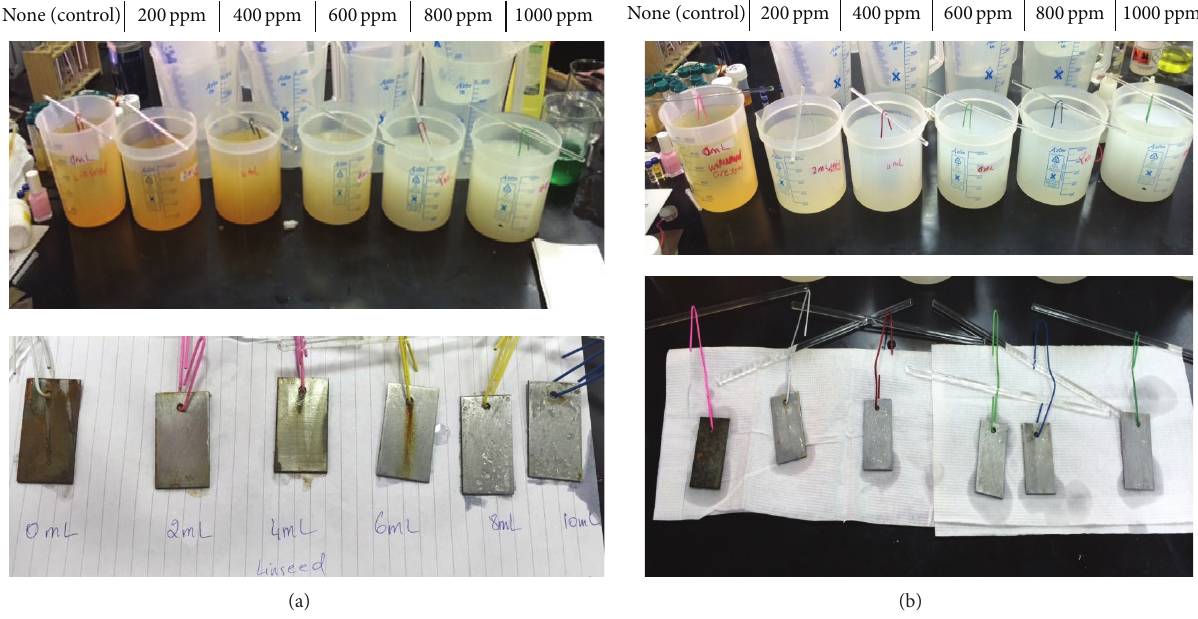
Figure 4: (a) Linseed oil derived CI in tap water: one-week immersion of carbon steel coupon. (b) Cress seed oil derived CI in tap water: eight-day immersion of carbon steel